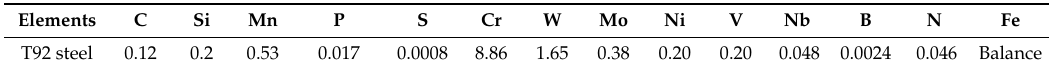
Table 1. Chemical composition (wt.%) of the T92 heat-resistant